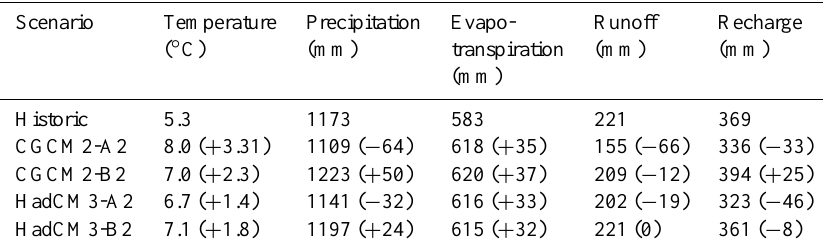
Table 7. Summary of mean annual temperature and hydrologic cycle components (precipitation, evapotranspiration, surface runoff and groundwater recharge) simulated with the HELP model for the historical period (1970-2001) and the four climate scenarios (2040-2069) in Prince Edward Island. Values provided in brackets are the change in mm or o C for the 2040-2069 period compared to historical conditions (1970-2001). Scenario Temperature Precipitation Evapo- Runoff